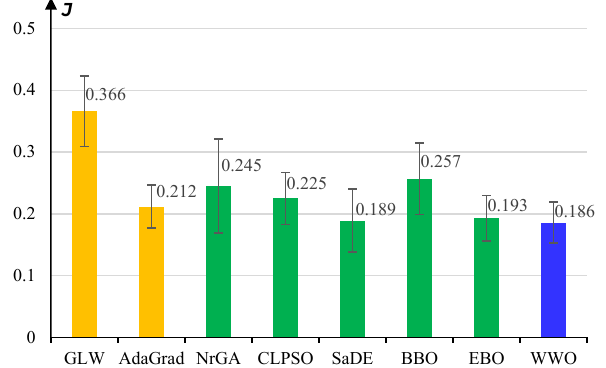
Figure 6. Average reconstruction errors and standard deviations of the comparative algorithms for pretraining the Control Learner